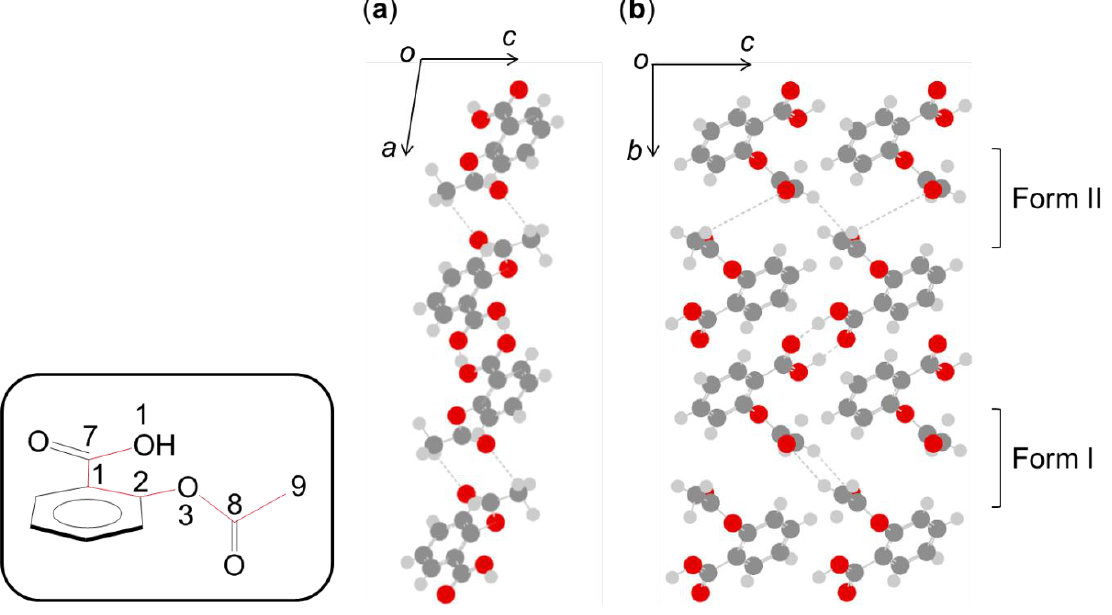
Figure 4. The polymorphism of aspirin. ( a ) One-dimensional chain structure of aspirin Form I; and ( b ) the difference in the hydrogen-bonded networks of Forms I and